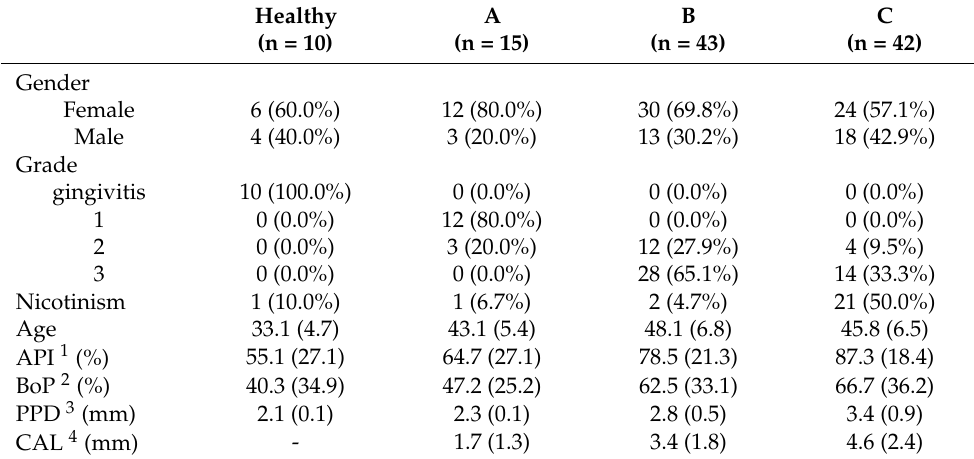
Table 3. Demographic characteristics.